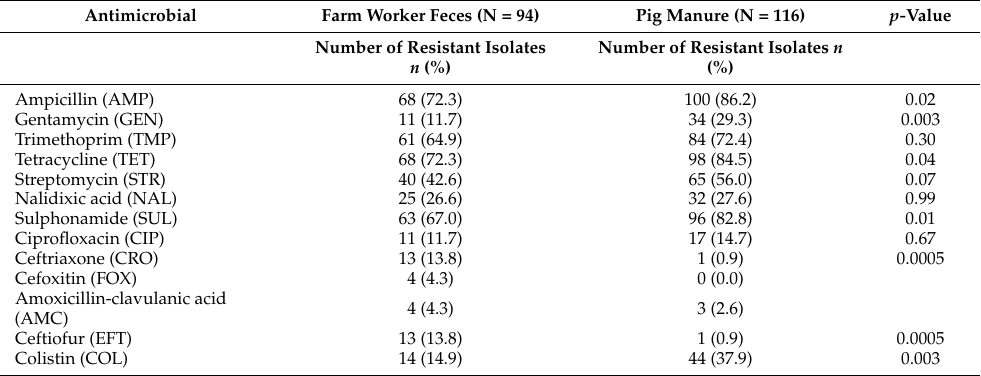
Table 1. Prevalence of antimicrobial resistance in E. coli isolated from pigs and pig farm